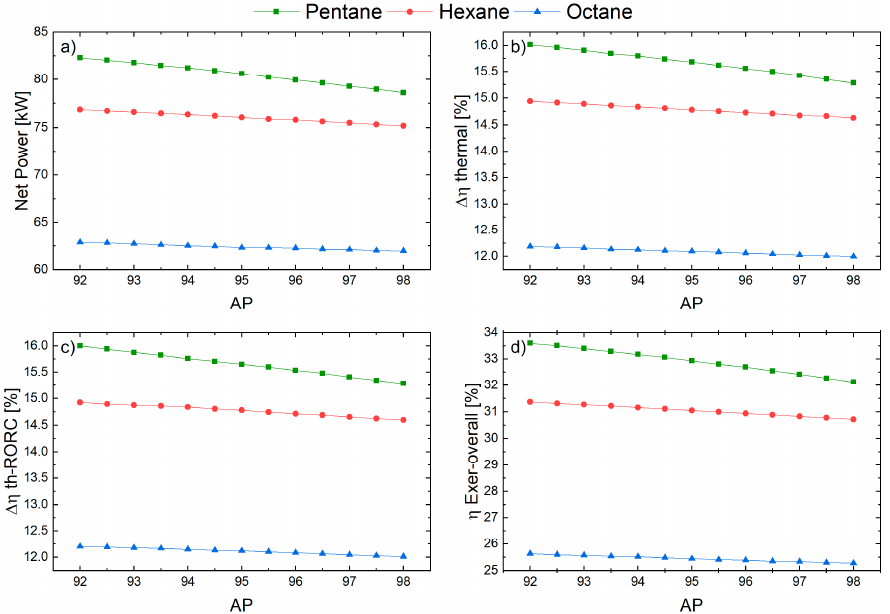
Figure9. Performanceofdi ff erentfluidsforaRORCsystemwithvaryingAP.( a )Netpower; ( b )Absolute increase in thermal e ffi ciency; ( c ) RORC thermal e ffi ciency; and ( d ) Global exergetic e ffi